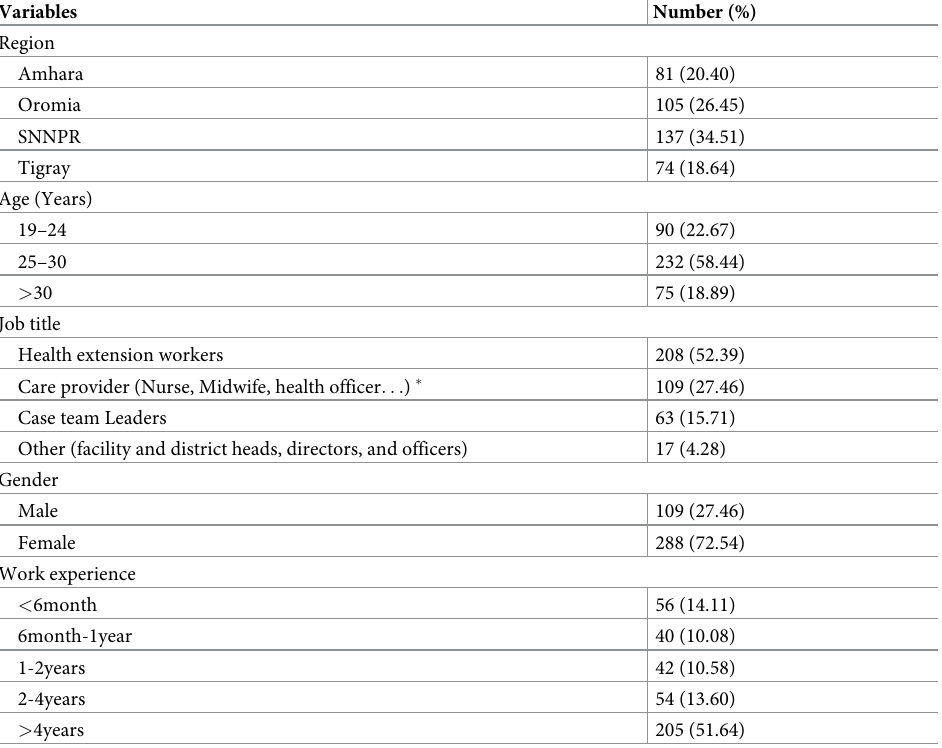
Table 2. Background characteristics of participants from four regions, (n = 397), April 15–May 10, 2018.